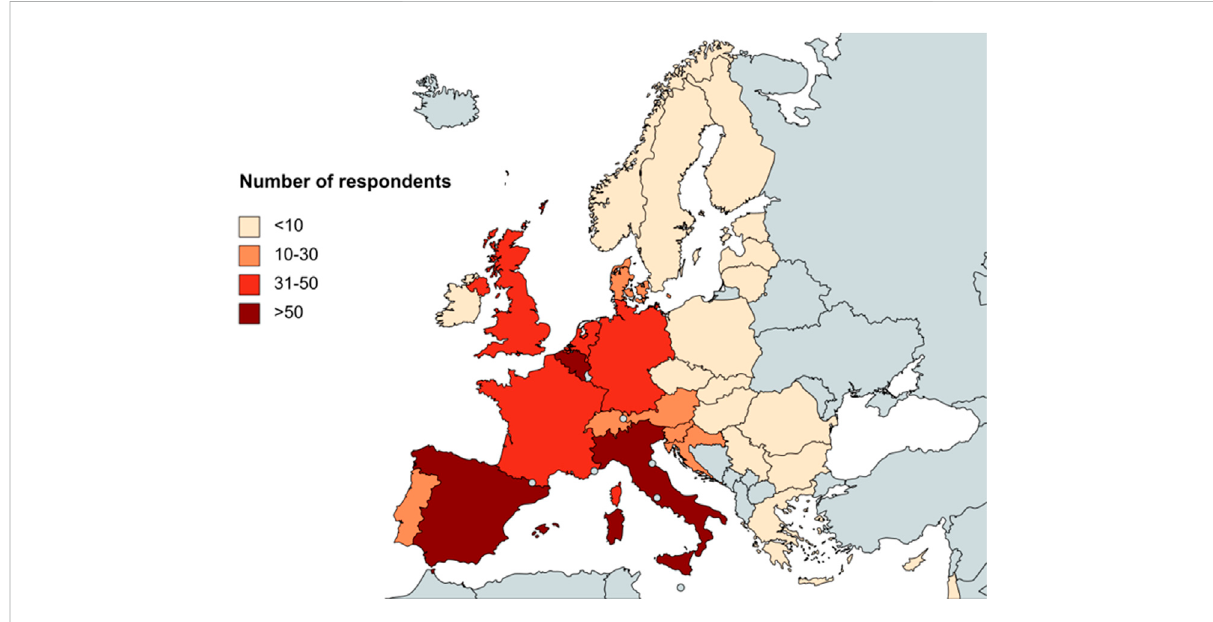
FIGURE 1 Overview of the number of survey participants per country.